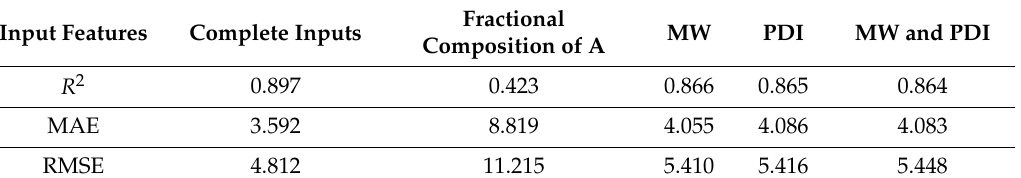
Table 5. The R 2 , MAE, and RMSE of the DNN model prediction when di ff erent input variables are estimated with their corresponding mean values.